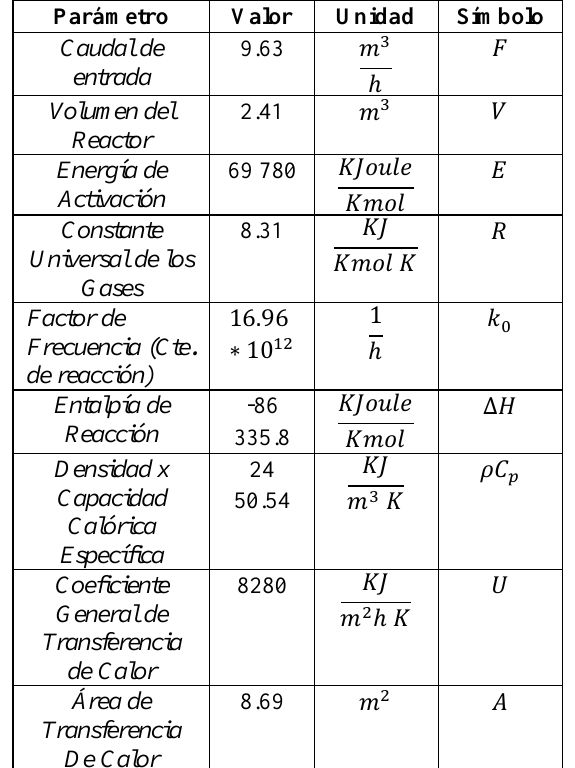
Tabla 1: Parámetros de la reacción de producción de